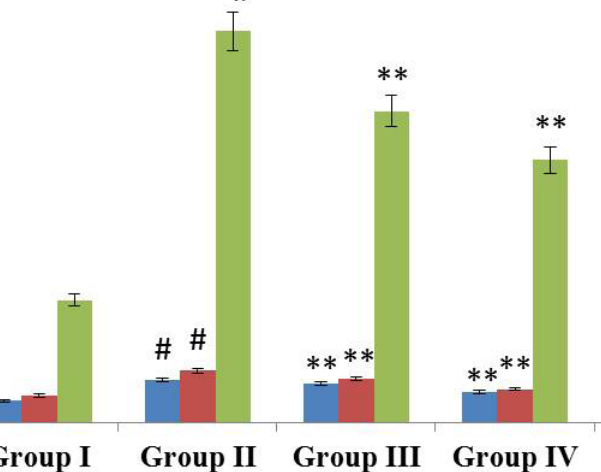
FIGURE 2 - Effect of ginkgolic acid on SGOT, SGPT and ALP enzymes in CFA-induced arthritic rats. Values expressed as mean ± SEM (n = 8) and analyzed by one-way ANOVA followed by Tukey’s multiple comparisons test. # p < 0.05 as compared to normal control group I. ** p < 0.01 as compared to CFA group